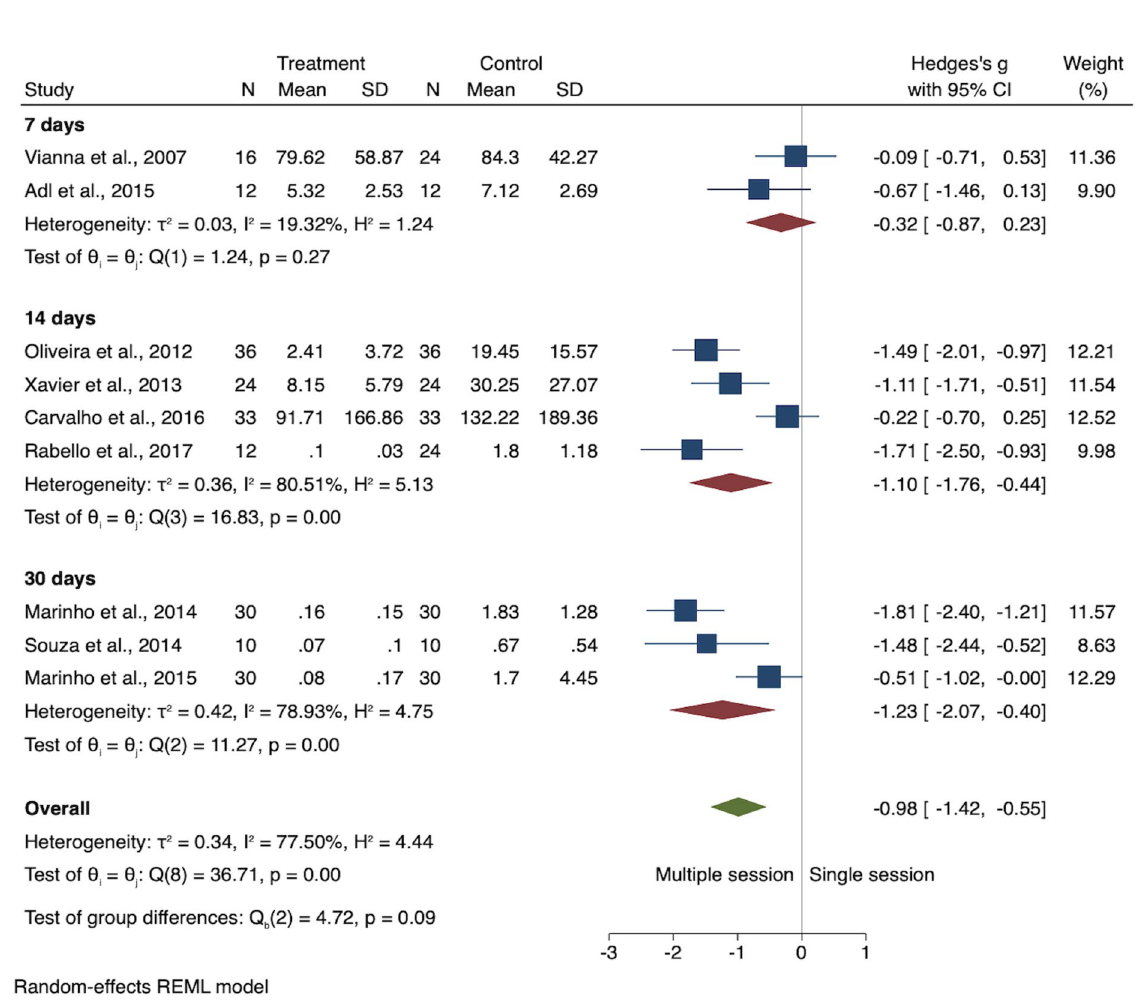
Figure 5. Forest plot for the endotoxin levels for single and multiple-session using calcium hydroxide medication for 7, 14, and 30